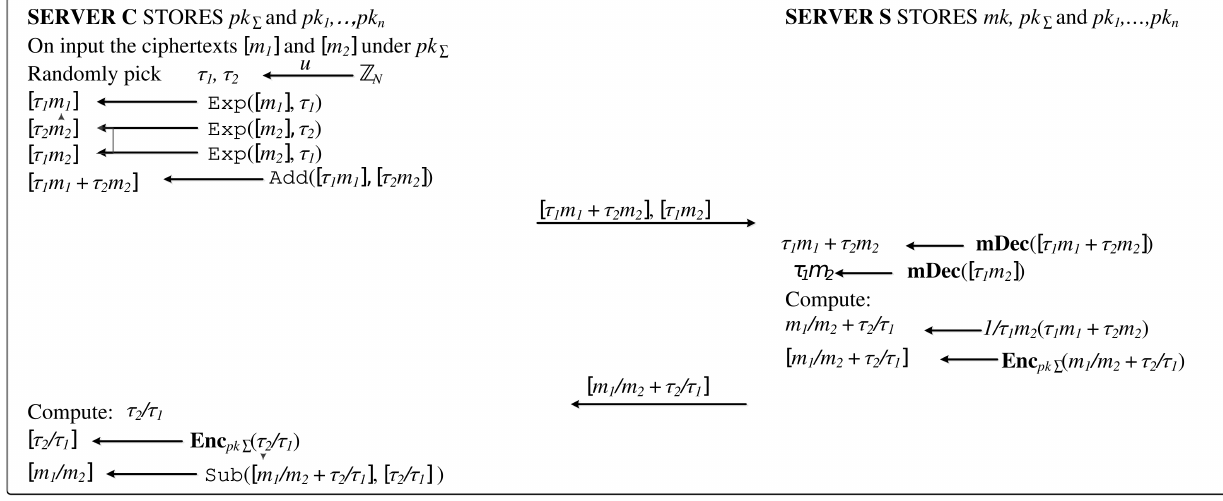
Figure 1. Illustration of the Div sub-protocol.